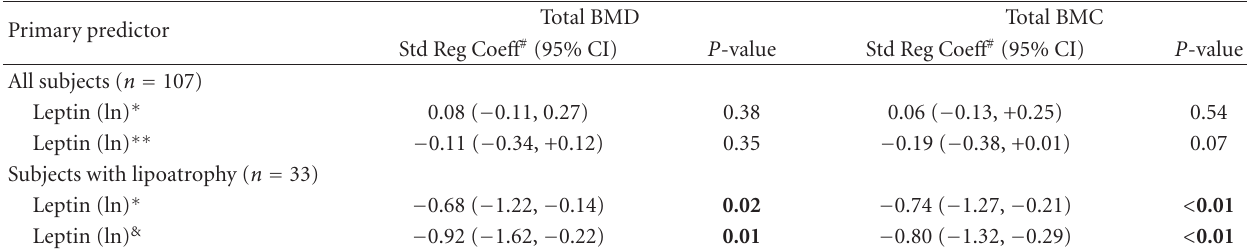
Table 2: Multivariate regression